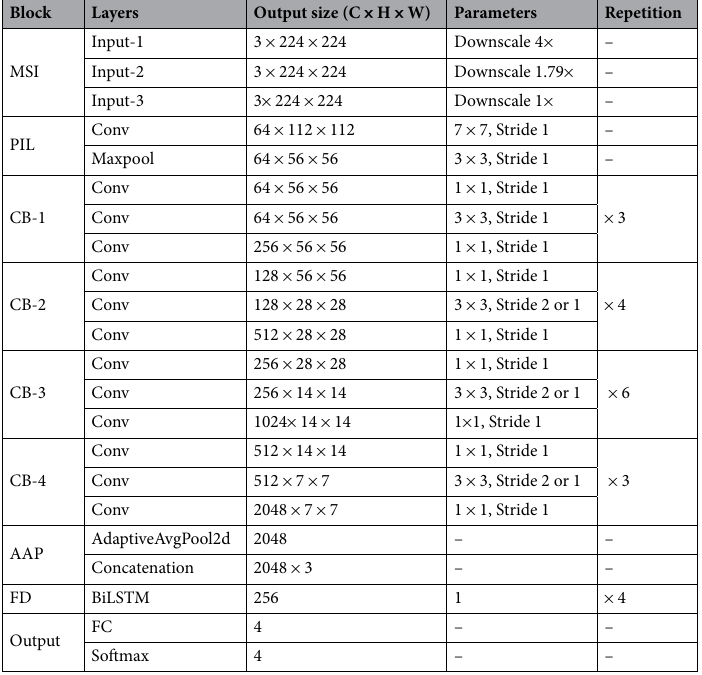
Table 1. The architecture of MSMV-PFENet. “Conv” layer shown in the table corresponds to the sequence BN-ReLU-convolution (BN, batch normalization; ReLU, rectified linear unit); FC: fully connected layer.